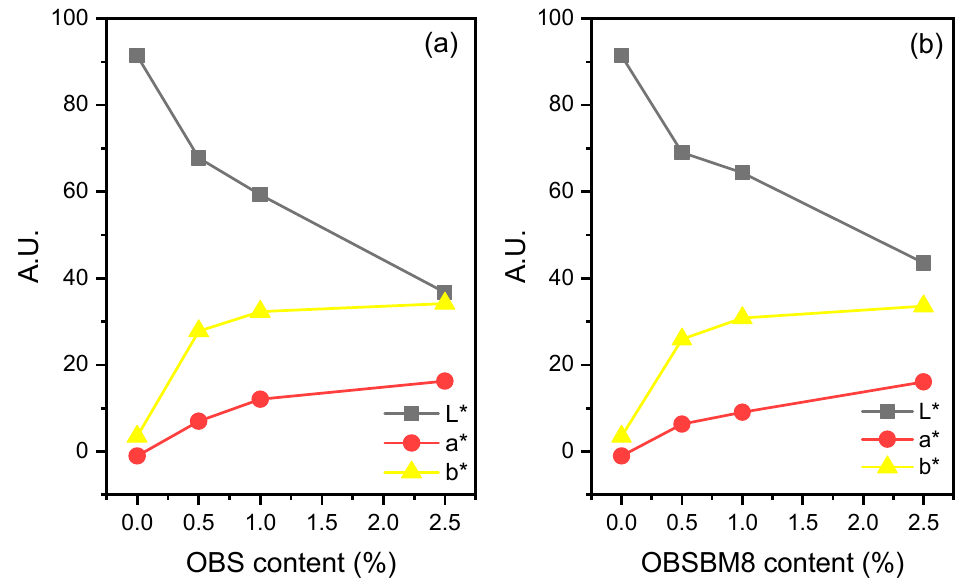
Figure 4. CIE L*a*b* Coordinate of PLA and its composites with ( a ) OBS lignin, ( b ) OBSBM8 lignin. L*: perceptual lightness, a* and b*: red–green and blue–yellow.